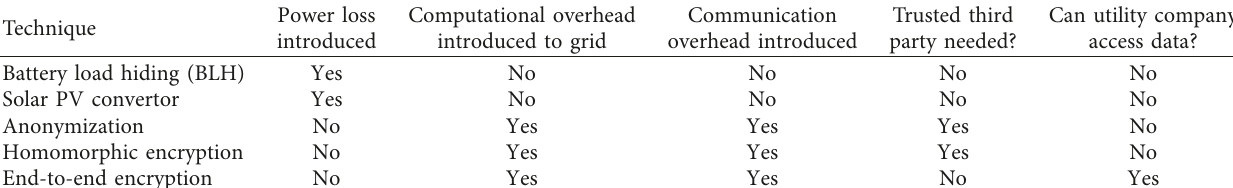
Table 1: Comparison of various privacy enhancing